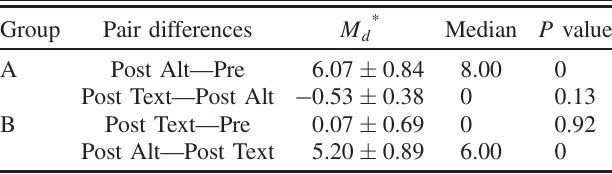
TABLE II. Overall gain scores between two surveys in com- parison ( n ¼ 15 for each group).